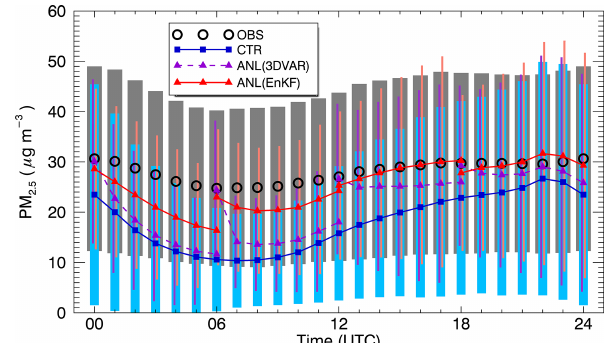
Figure 5. Average diurnal variations of PM 2 . 5 aggregated from all ground stations in South Korea (D2) for the DA_ic experiment. The color labels are the same as in Fig. 1, except for symbols. The error bars with gray, cyan, purple, and pink indicate 1 standard deviation ( ± σ ) for OBS, CTR, ANL by 3D-Var, and ANL by EnKF simula- tions,